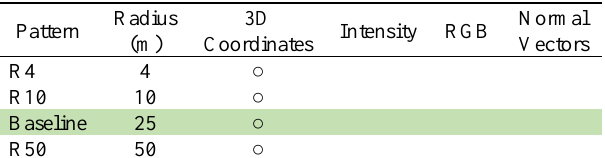
Table 2. Comparison of different neighborhood radii.